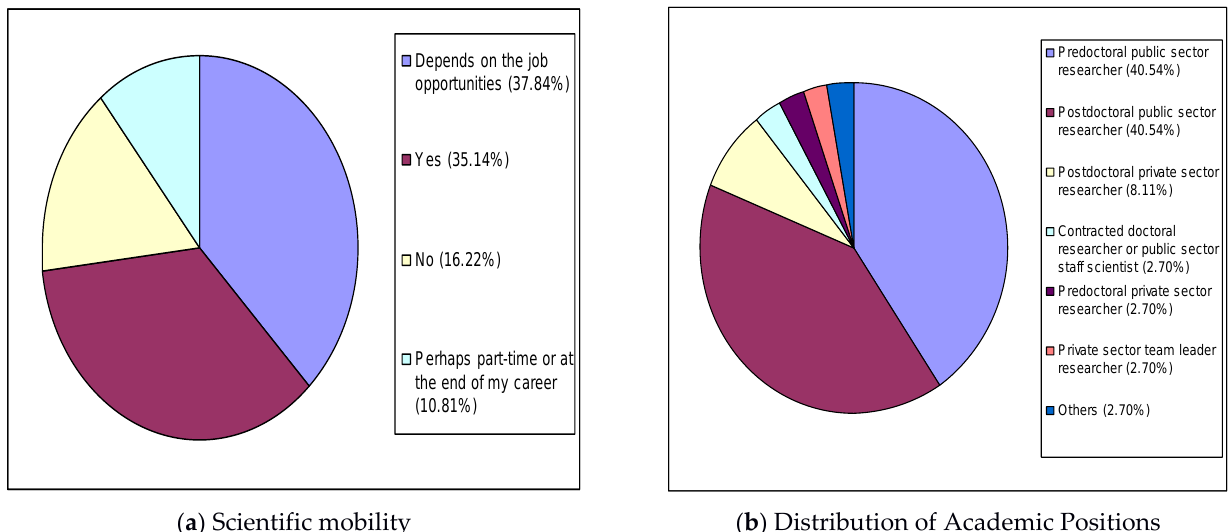
Figure 3. Profile of health sciences young researchers in Spain. ( a ) Scientific mobility. ( b ) Distribution of Academic Posi- tions